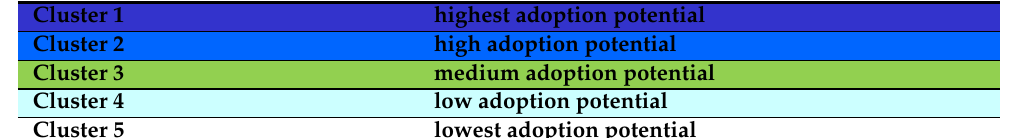
Table 3. PA adoption clusters’ description.